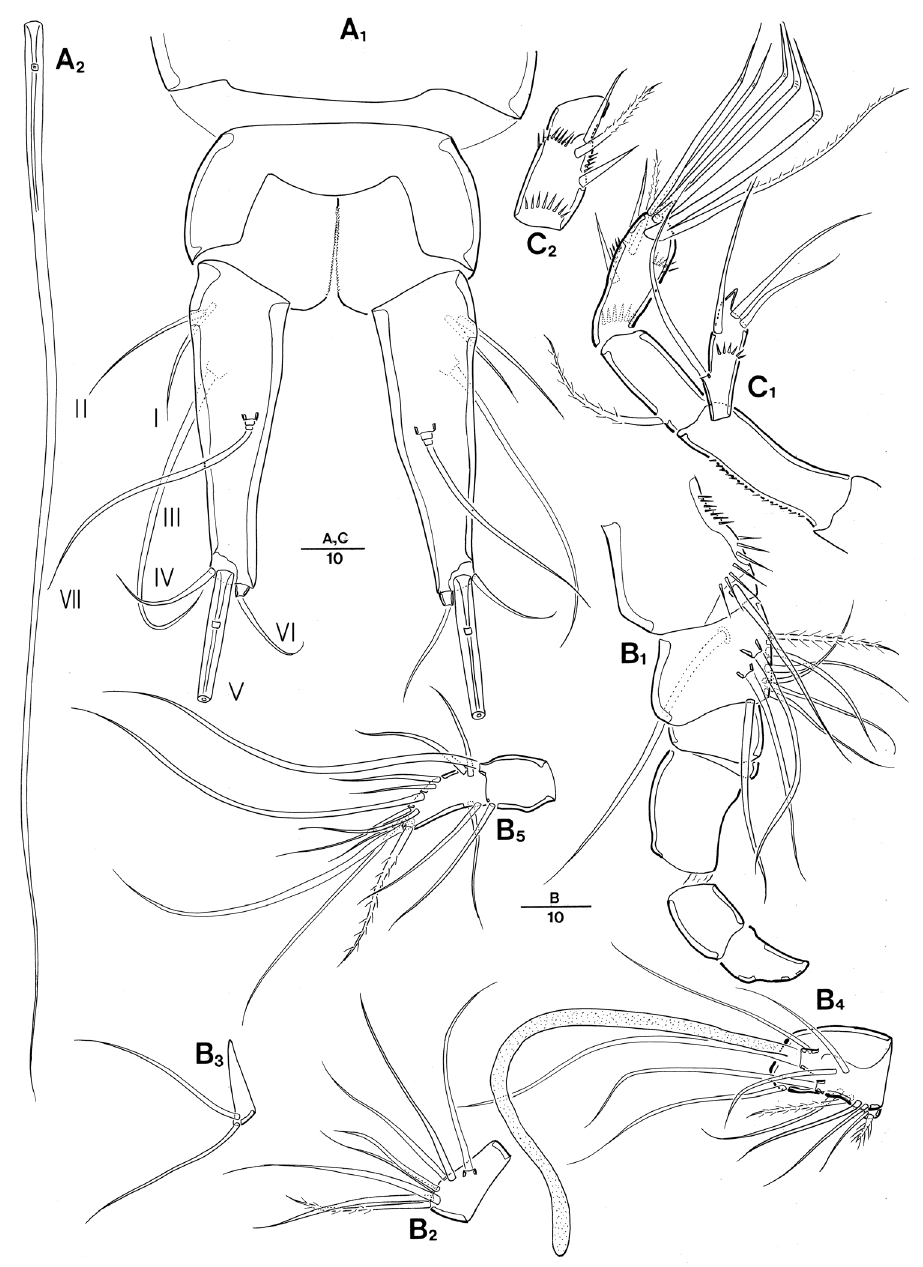
Figure 6. Leptopsyllus ( Leptopsyllus ) koreanus sp. n. ( ♂ ). A A seta V B segments-1 and -2 of antennule B 2 1 and -7 C antenna C endopod-2 of antenna, lateral. Scale bars are in 1 2